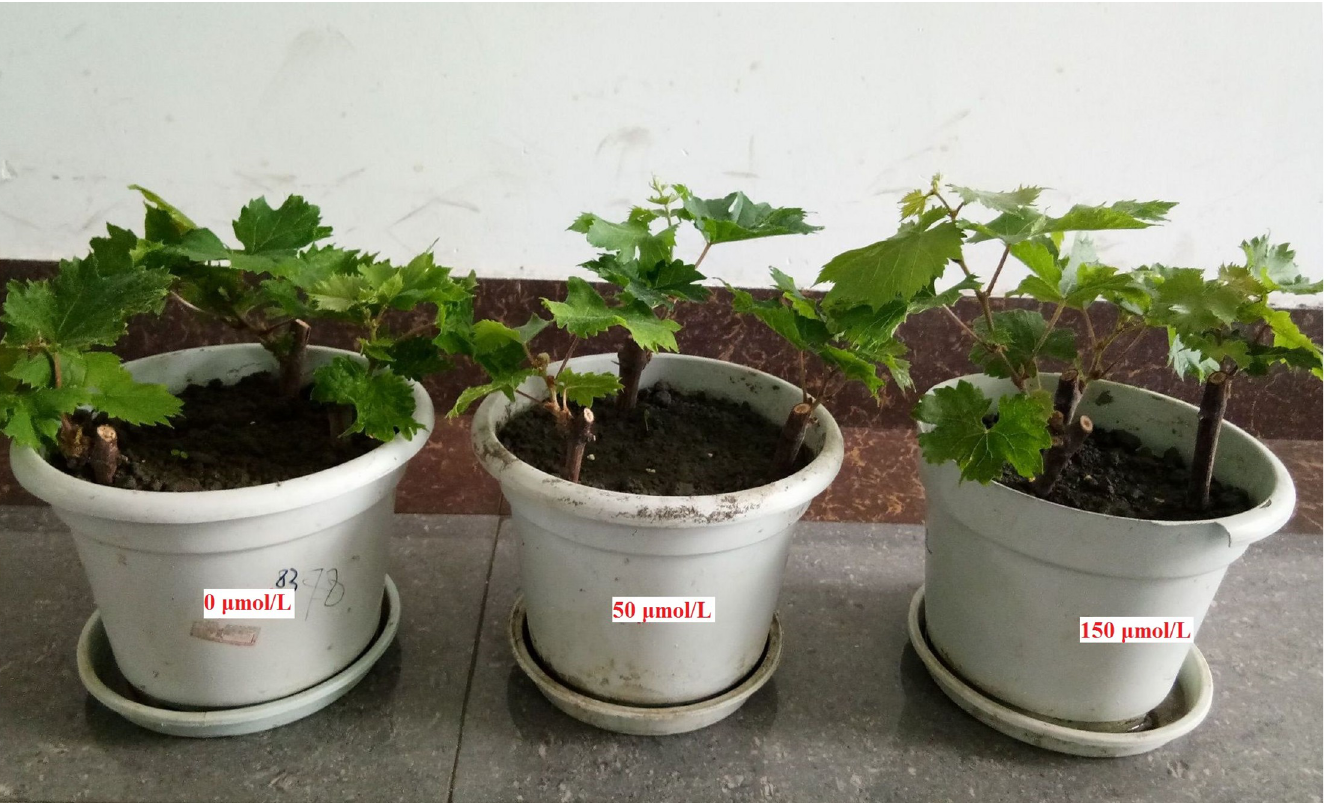
Fig 1. Effects of MT on the growth of grape